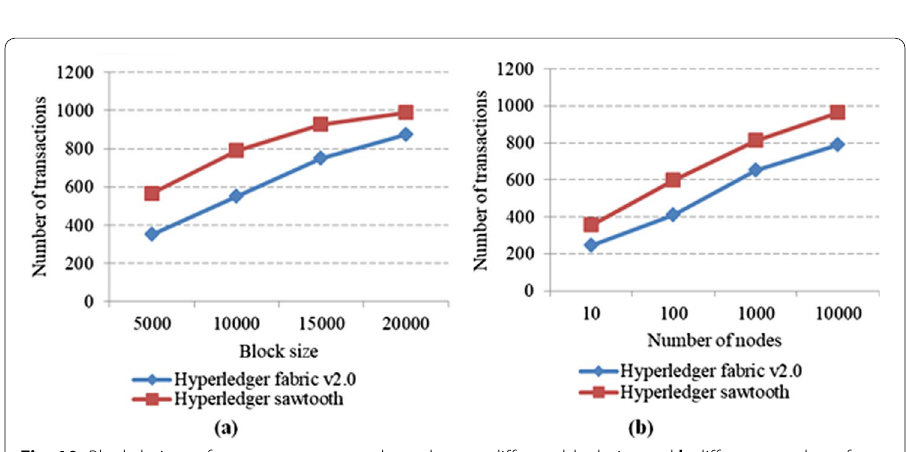
Fig. 10 Blockchain performance parameter throughput: a different block size and b different number of nodes. Performance parameter throughput of the blockchain is presented in graphical form. Throughput of the system is tested by variation in block size and number of nodes. a Throughput of system when different block size is used in blockchain using Hyperledger fabric 2.0 and sawtooth is represented. b Throughput of system when different number of nodes when same block size is used when implemented using Hyperledger v2.0 and sawtooth is graphically